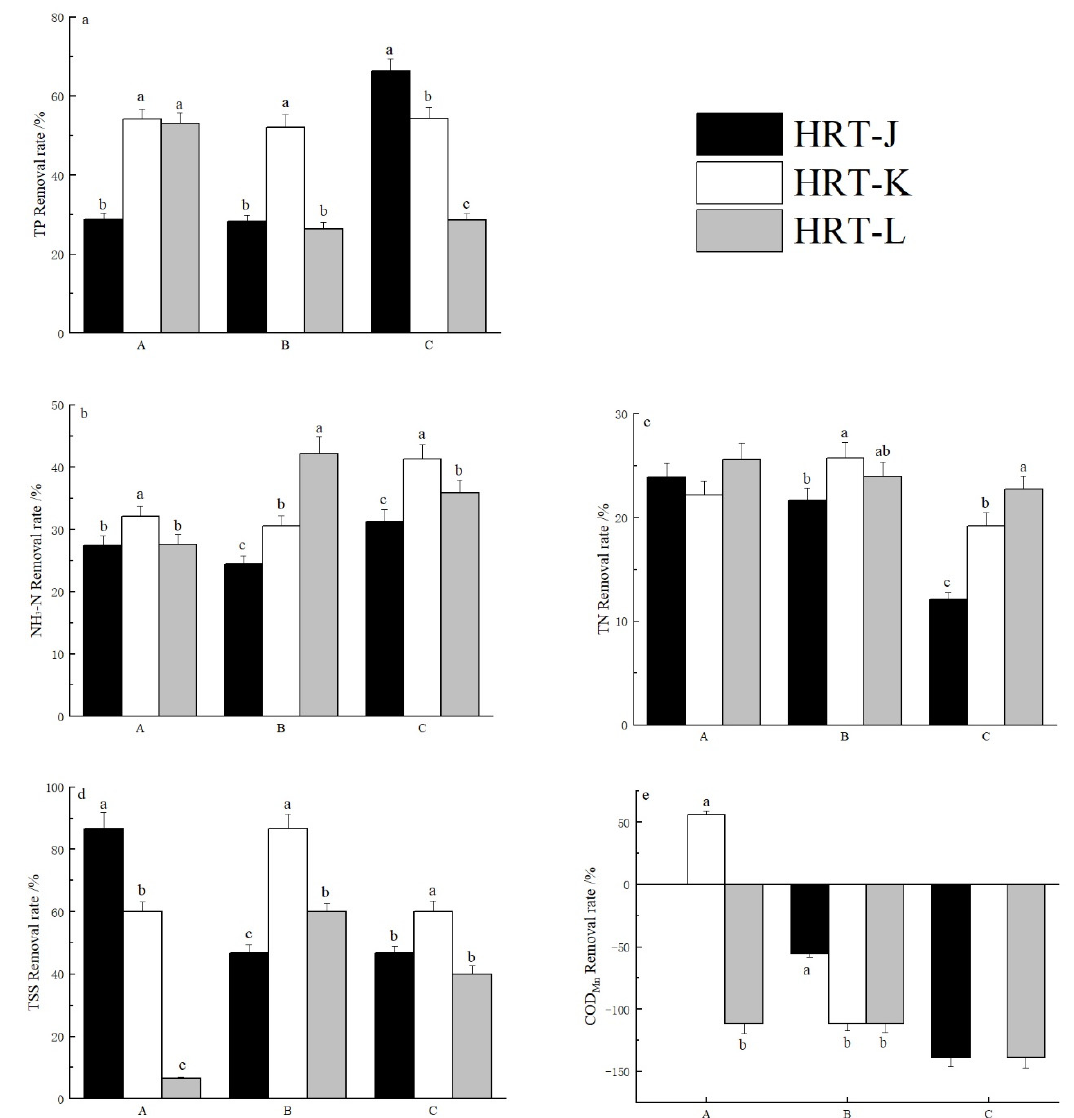
Figure 4. Removal rate of aquaculture wastewater by wastewater treatment device under residence time of different water bodies. ( a ) TP, ( b ) NH 3 -N, ( c ) TN, ( d ) TSS, ( e ) COD Mn . Wastewater treatment effects under different unit ratios were analyzed. When the ratio of each unit at all levels was 1:1:1, removal rates of TP, TN, NH 3 -N, and TSS reached 20–50%, 20%, 25–40%, and 40–60%, respectively (Figure 5). When the ratio was 2:1:1, removal